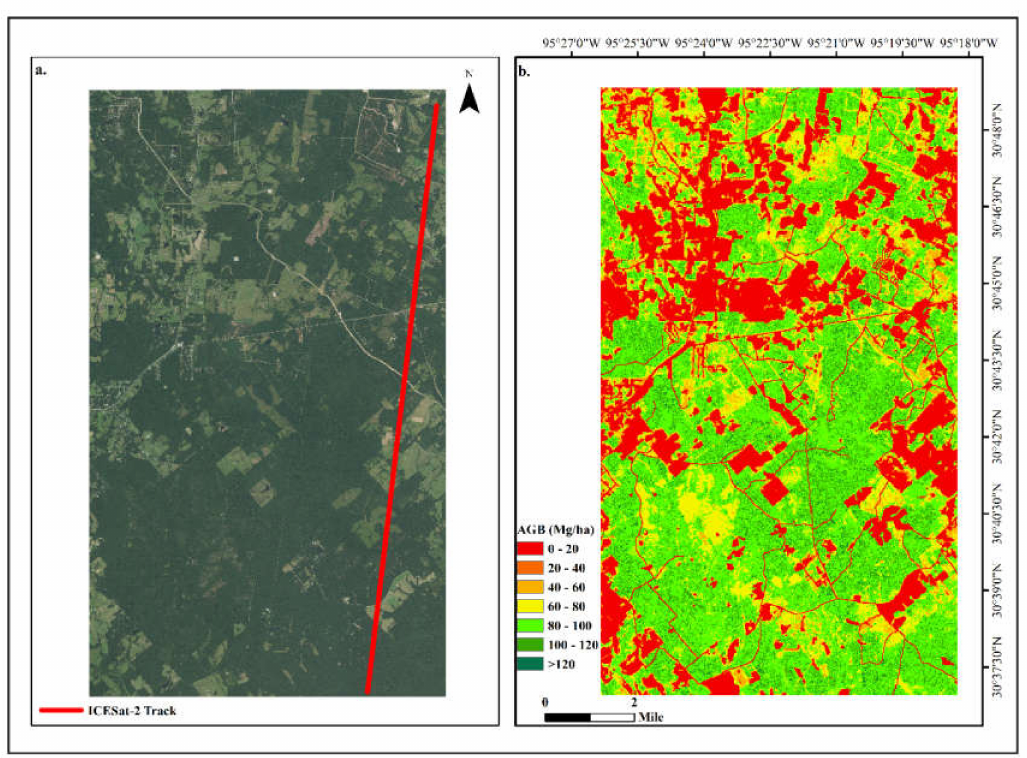
Figure 6. ( a ) Map of study area showing ICESat-2 transect analyzed, overlaid on 2016 natural color National Agriculture Imagery Program (NAIP) imagery; ( b ) predicted AGB density for the study area (30 m grid